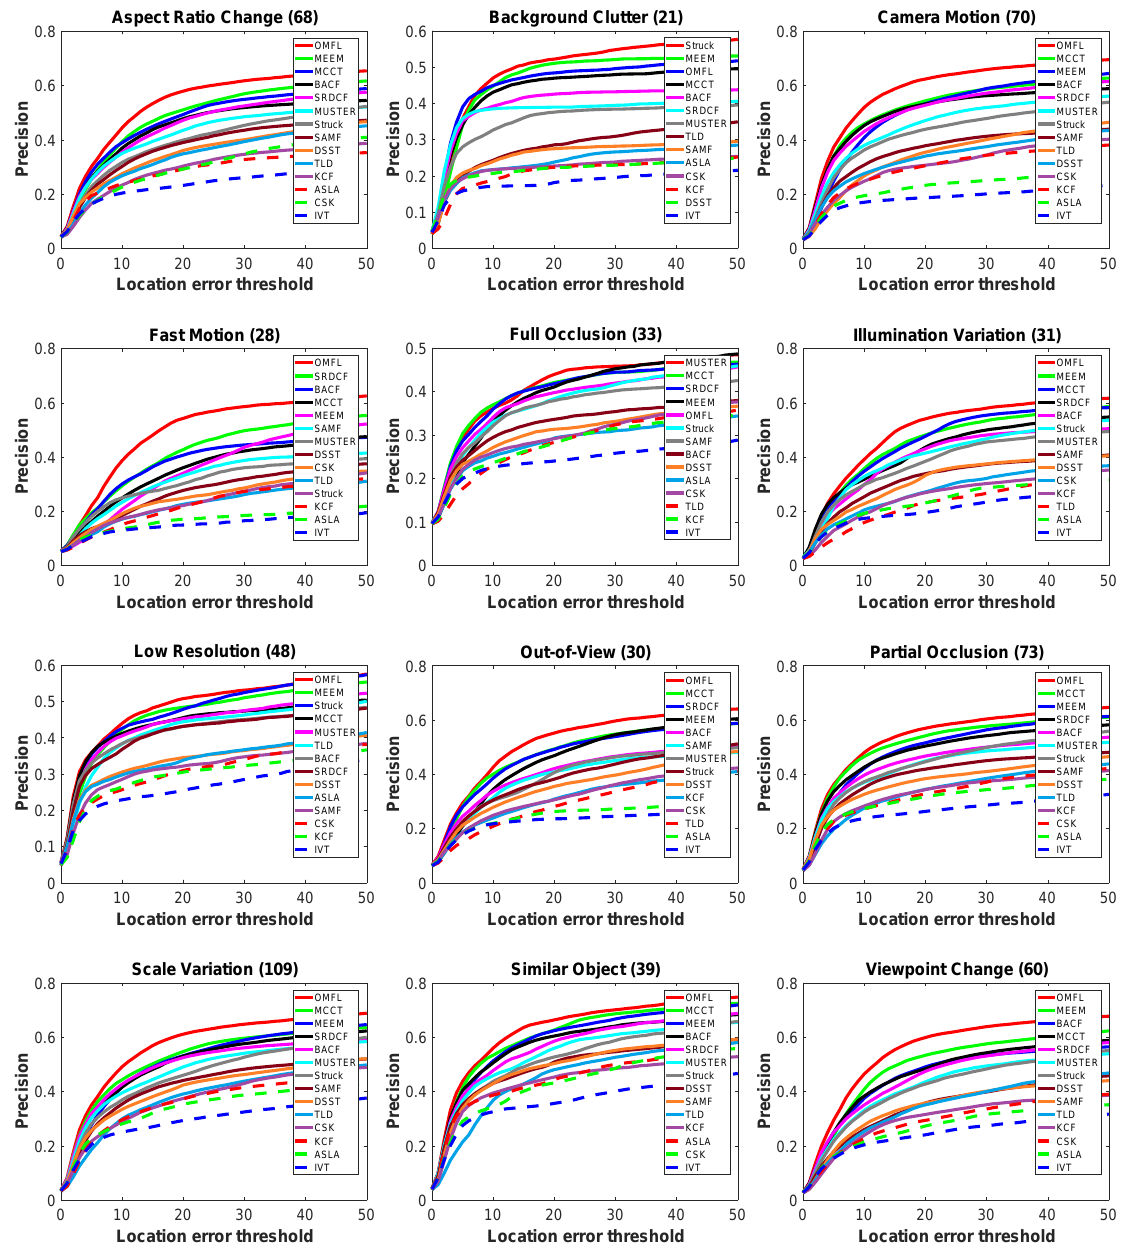
Figure 14. Precision plots on different